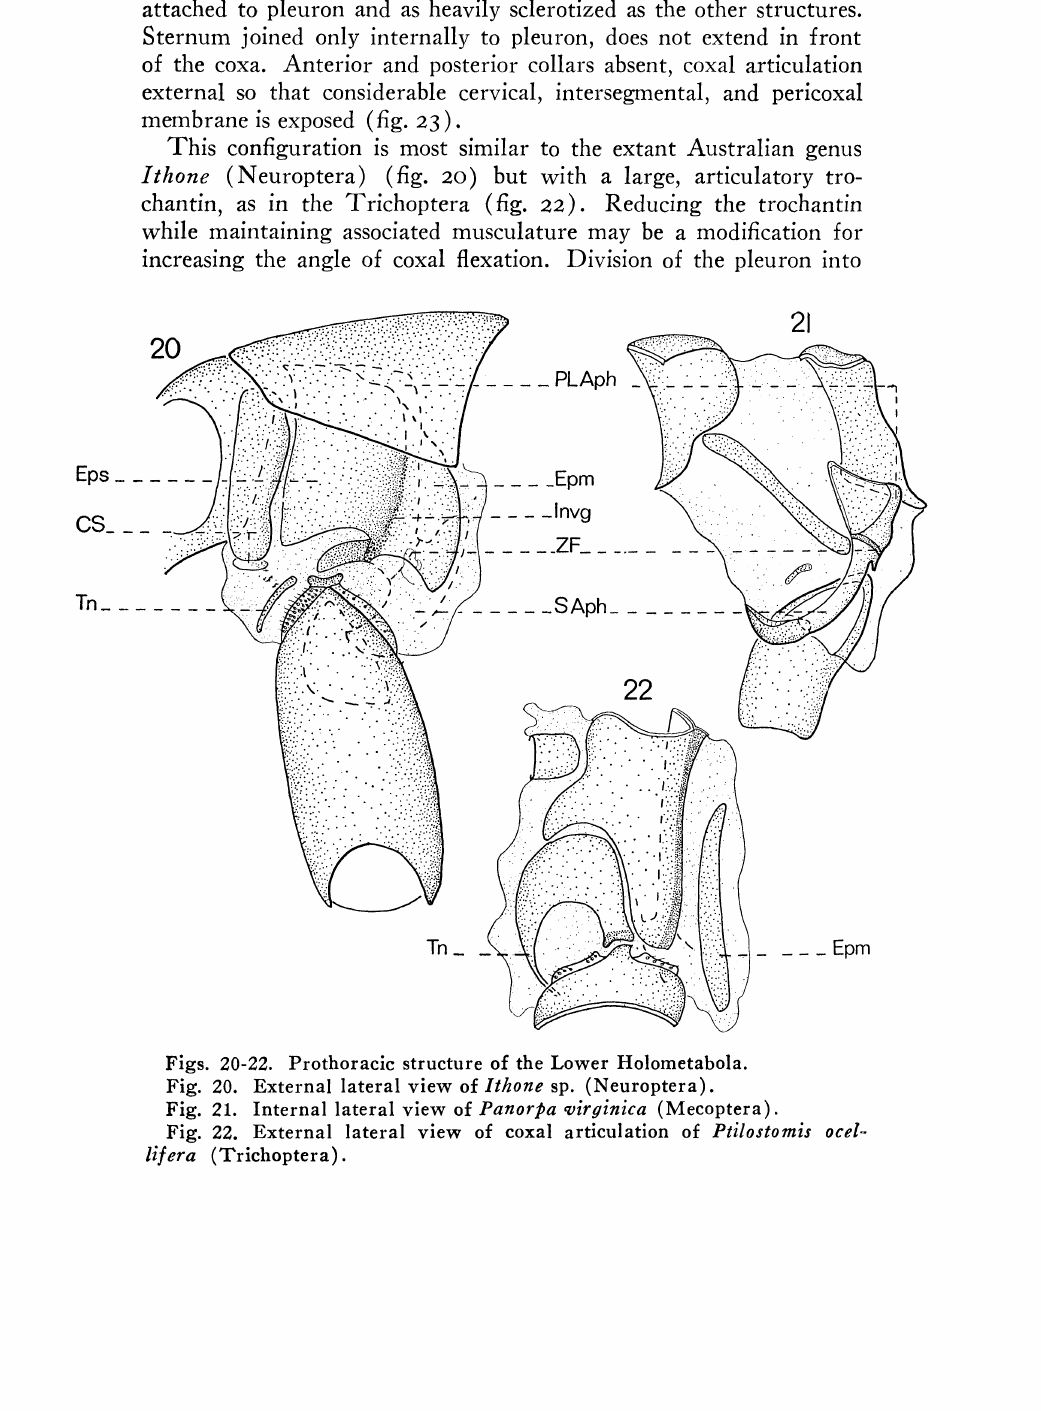
Figs. 20-22. Prothoracic structure of the Lower Holometabola. Fig. 20. External lateral view of Ithone sp. (Neuroptera). Fig. 21. Internal lateral view of Panorpa irtlinica (Mecoptera). Fig. 22. External lateral view o coxal articulation of Ptilostomis ocel- liera